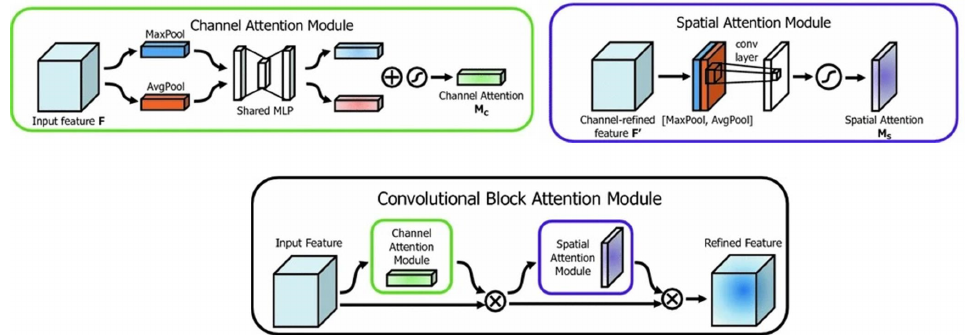
Figure 5. CBAM structure diagram [14].